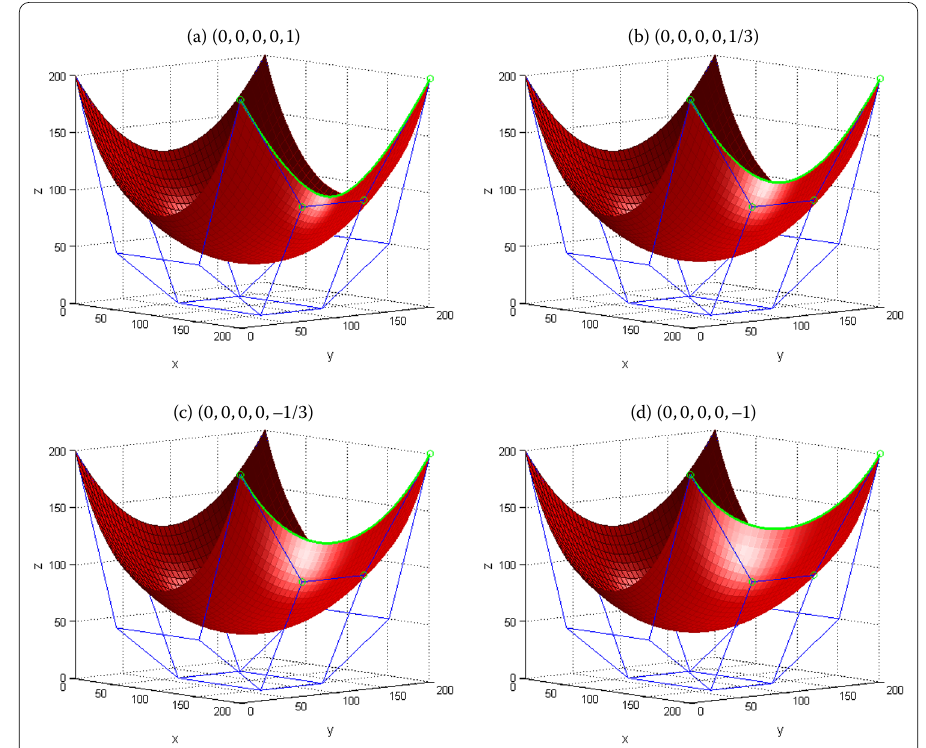
Figure 3 Generalized Bézier-like surfaces of degree (3,3) with different shape parameter γ 3 .